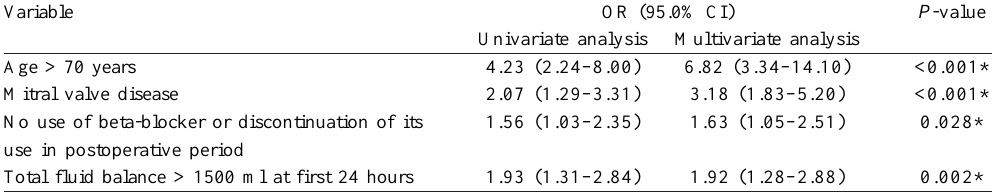
Table 4. Multivariate logistic regression model